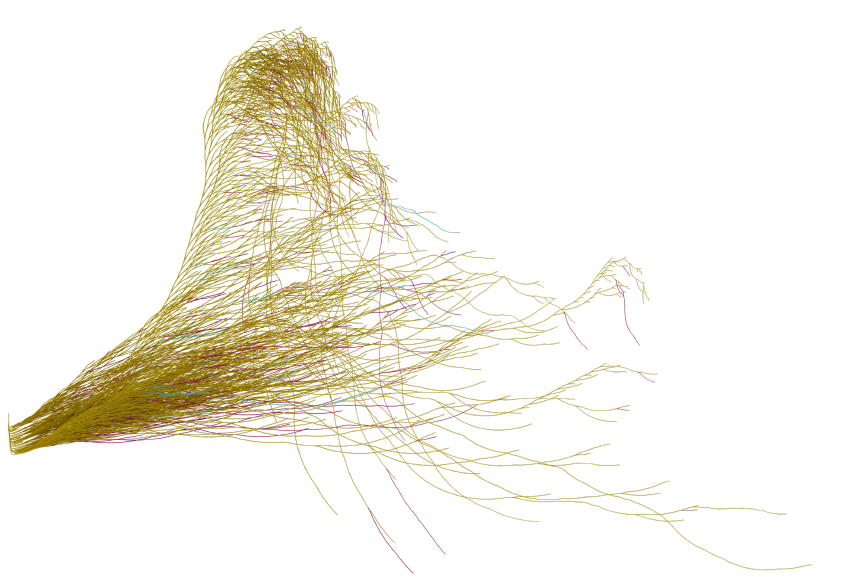
Figure 3. Collatz feather rendered in Blender, this time with the same ternary typology as defined in Definition 4 [42].